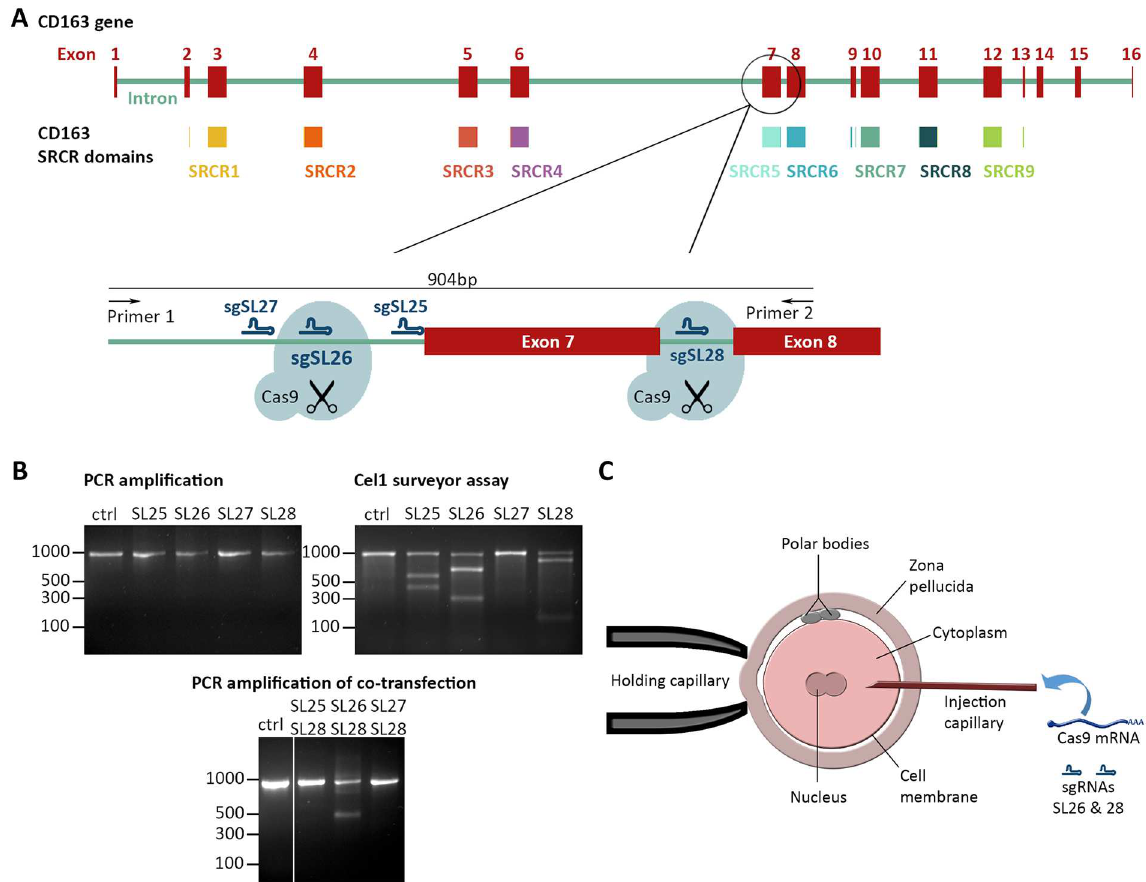
Fig 1. Generation of an exon 7 deletion in CD163using CRISPR/Cas9. A) Schematic of the CD163 gene in the pig genomeon chromosome 5. Indicatedin red are the 16 exons encodingthe CD163mRNA, in variedcolors underneathare the 9 scavenger receptorcysteine-rich (SRCR) domainsthat form the pearl on a string structure of the CD163protein. Excision of exon 7 using two guide RNAs (sgSL26 & sgSL28) locatedin the flankingintrons should result in SRCR 5 removalfrom the encodedprotein. Indicated are also the locationsof sgRNAs SL25 and SL27. B) In vitro assessment of guide RNAs sgSL25, sgSL26, sgSL27, and sgSL28. PK15 cells were transfected with either a singleplasmid encoding a guide RNA + Cas9 or co-transfected with combination of two such plasmids. Transfected cells were identifiedby GFP expressionand isolated by FACS. Cutting efficiencyof single guide RNA transfectionwas assessedby a Cel1 surveyor assay. Relativeefficiencyof exon 7 deletionupondoubletransfectionwas assessed by PCR. C) Schematicof the Cas9/guideRNA injectioninto zygotes. The injectionmix was injected into the cytoplasm of zygotes and containeduncapped, non-polyadenylated guide RNAs sgSL26and sgSL28, as well as capped, polyadenylatedCas9